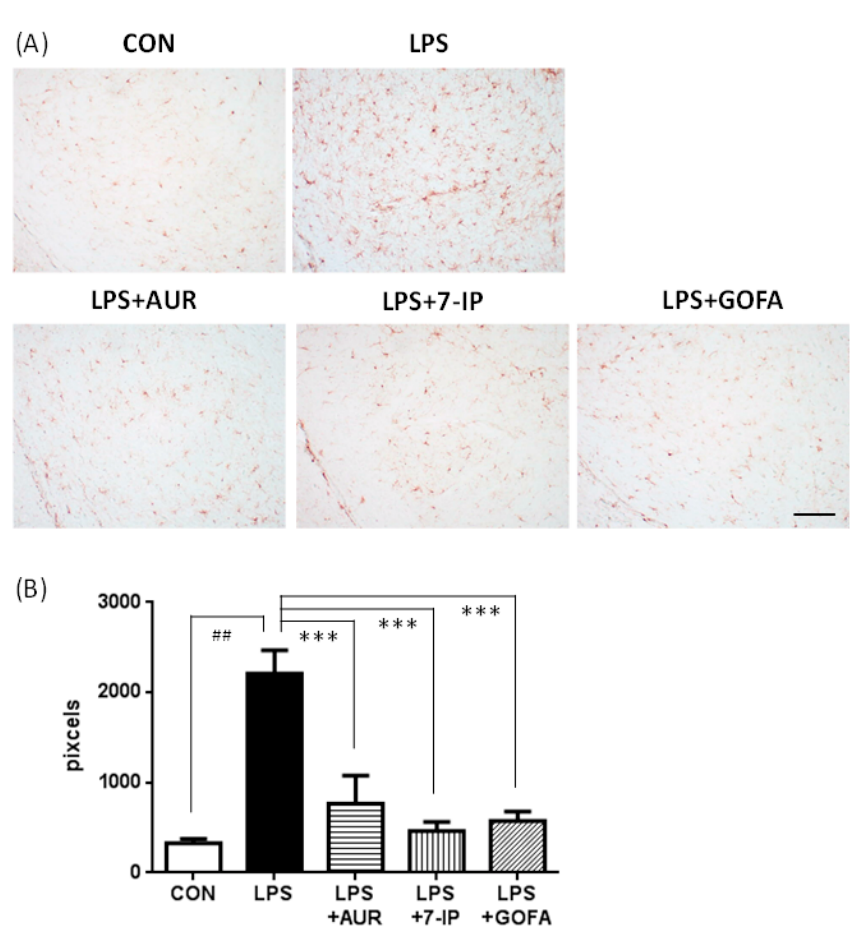
Figure 3. Effects of AUR, 7-IP, and GOFA on LPS-induced microglial hyperactivation in the substantia nigra. ( A ) Representative micrographs of IBA1-positive cells on day 22 in the indicated groups. Scale bar = 100 μ m; ( B ) Total IBA1-positive cells signal densities. Values are the means ± SEM. Significant differences were observed between control (CON) and LPS ( ## p < 0.01) and between LPS and sample treatment groups (*** p < 0.001).